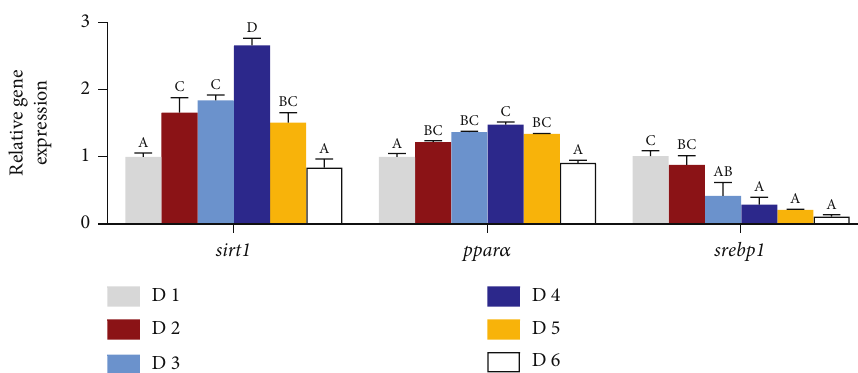
Figure 5: E ff ects of dietary lipid levels on lipid metabolism of juvenile Acanthopagrus schlegelii reared at low-salinity water. Values are means ( n = 3 ), with standard errors represented by vertical bars. Mean values for the same column with di ff erent superscript letters were signi fi cantly di ff erent ( P < 0 : 05 ). ppar α : peroxisome proliferators-activated receptor alpha; sirt1 : silent regulator 1; srebp-1 : sterol regulatory element-binding protein-1.